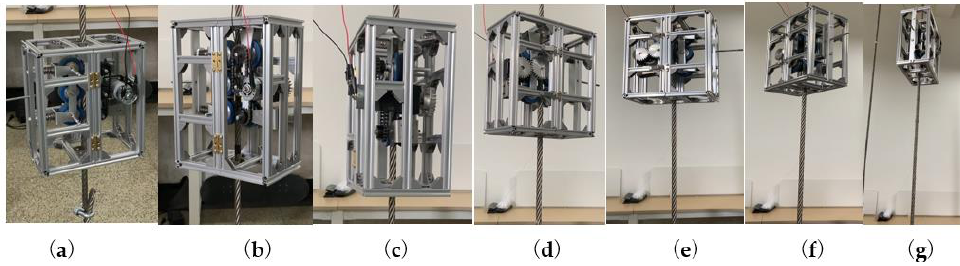
Figure 17. Process of obstacle negotiation. ( a ) t = 0 s, ( b ) t = 5 s, ( c ) t = 10 s, ( d ) t = 15 s, ( e ) t = 20 s, ( f ) t = 25 s, ( g ) t = 30 s.